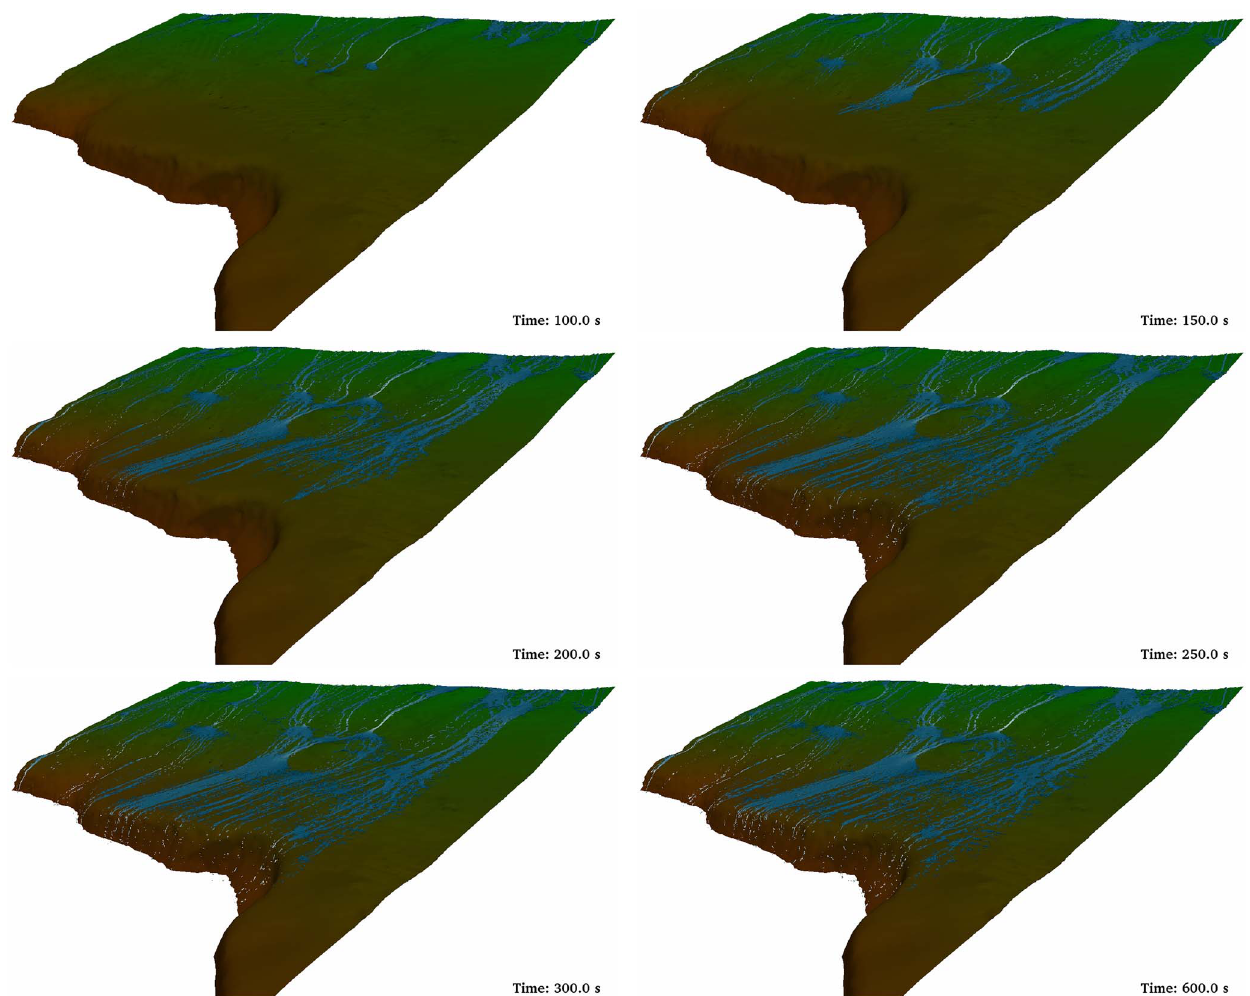
Figure 7. Different instants of the DualSPHysics simulation without ditch.